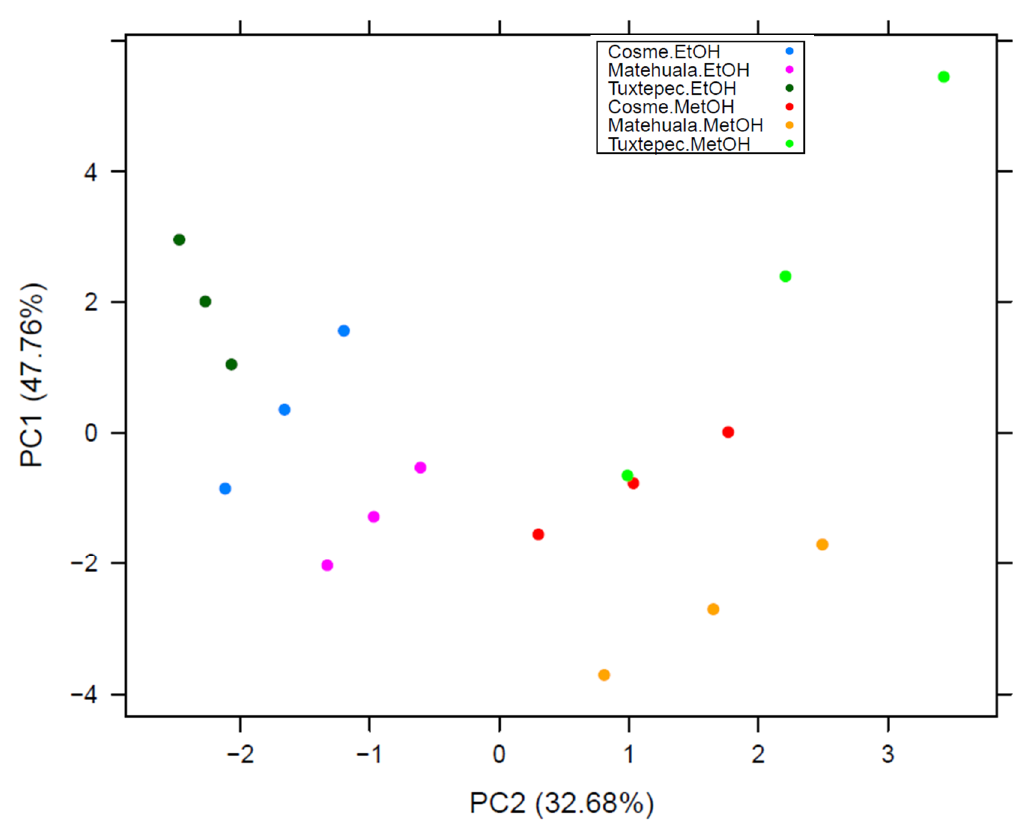
Figure 6. Plot of PCA analysis considering the flavonoids concentration in regard to extractive solvent and sampled site. Individually, kaempferol averaged 12.98 ± 0.83 µg/g DW and was not affected by